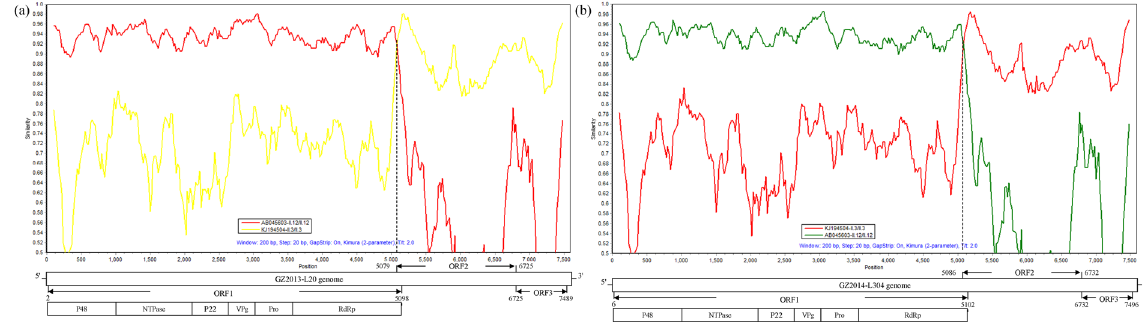
Figure 1. Recombination analyses of NoV Guangzhou strains using Simplot software: ( a ) GZ2013-L20 and ( b ) GZ2014-L304. The assay was performed using standard parameters of the program with a window size of 200 bp, a step size of 20 bp and with the Kimura (2-parameter) model. The y-axis indicates the nucleotide sequence similarity between the recombinant sequence and reference strains. The x-axis indicates the nucleotide position. The site where the two NoV parental strains of different genotypes have equal identity to the recombinant is the predicted site of recombination, which is marked with a black dotted